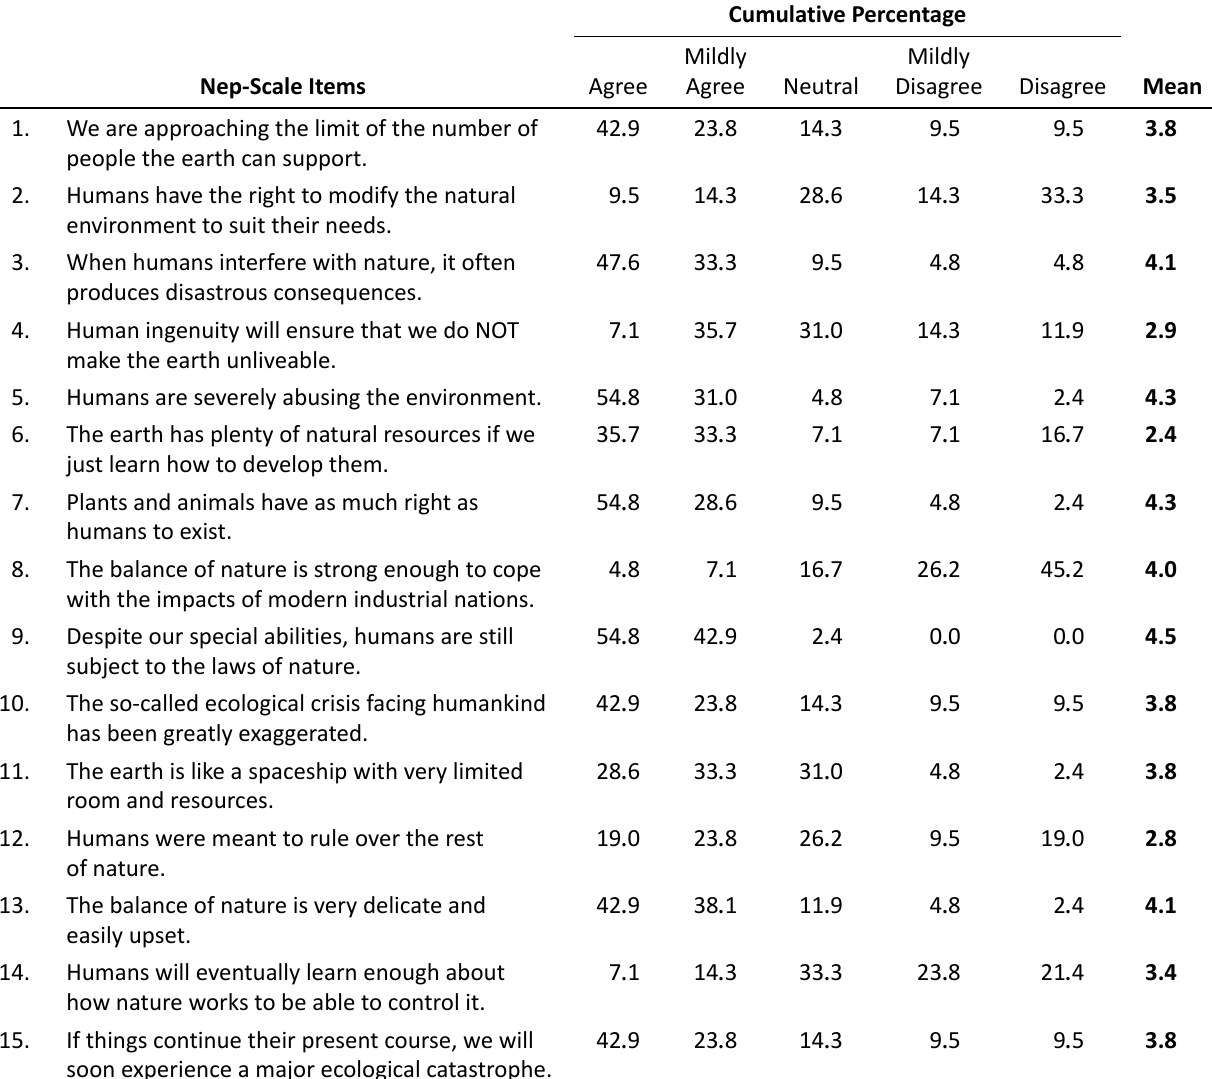
Table 2. Responses of the sample of South African urban planners to the NEP‐scale